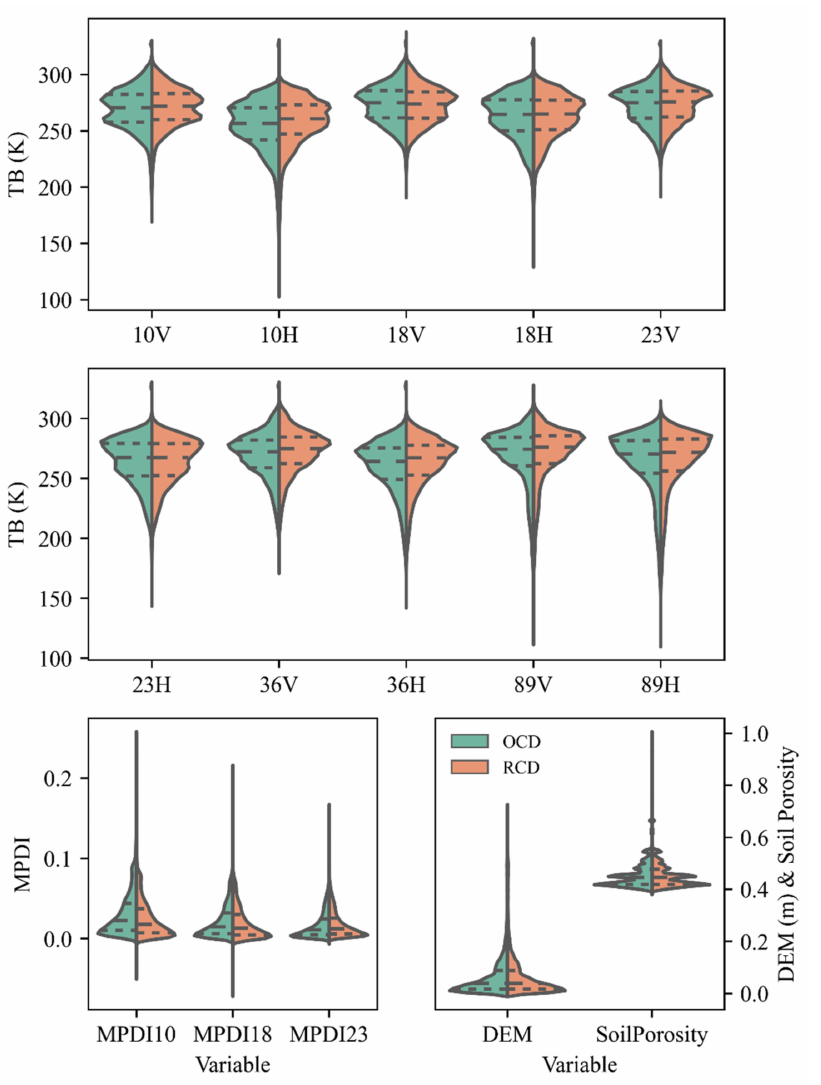
Figure 2. Distribution of TBs of all channels, MPDI, DEM and soil porosity in training datasets from OCD and RCD. Digit in x label denotes frequency, H and V denote horizontal and vertical polarization,